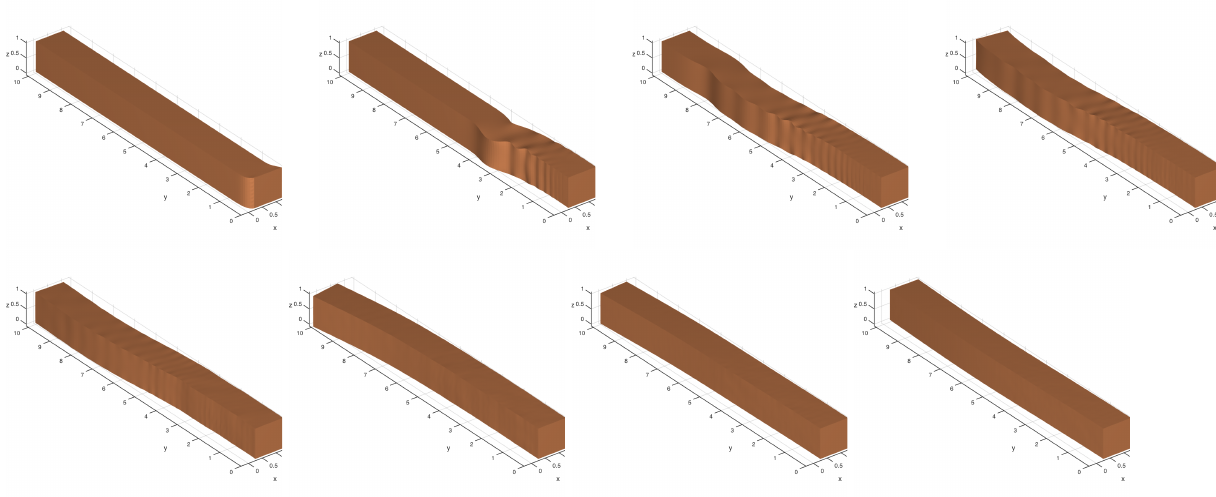
Fig. 10 The results of the same simulation as Figure 9, without the colormap. From left to right, then from top to bottom, time-step = 9, 30, 55, 70, 100, 200, 350,